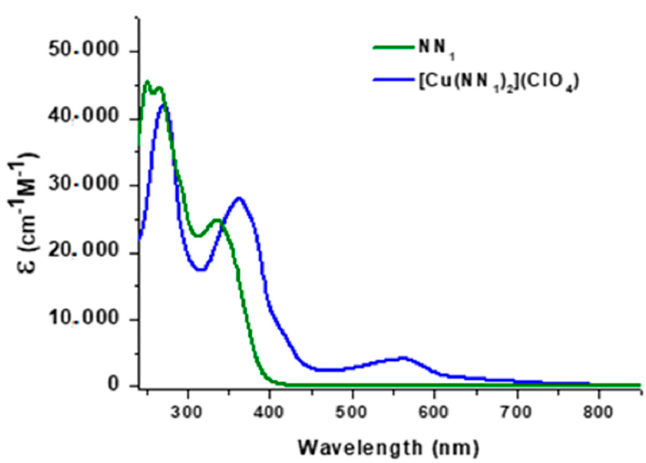
Figure 3. UV-Vis spectra for NN 1 ligand (green) and complex [Cu(NN 1 ) 2 ]ClO 4 (blue).